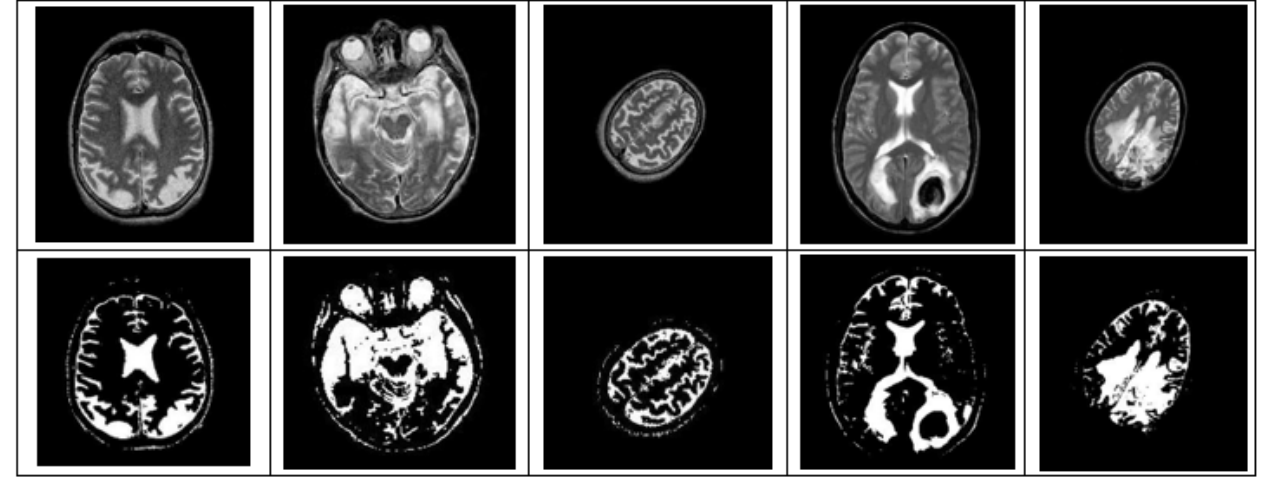
Figure 7. Scaling Invariant (0.25–1.5) Brain MRI Image Detected by